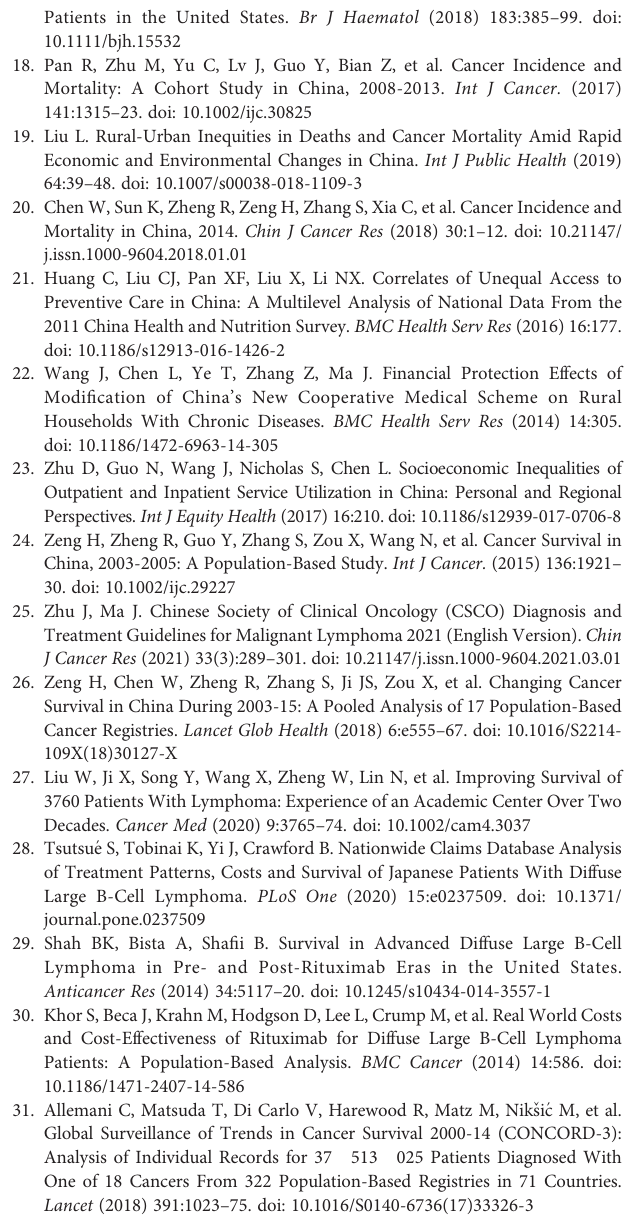
Supplementary Figure 2 | Mortality rate of lymphoma in females by provinces in 2020, China . (A ) Crude mortality rate; (B ) age-standardized mortality rate of